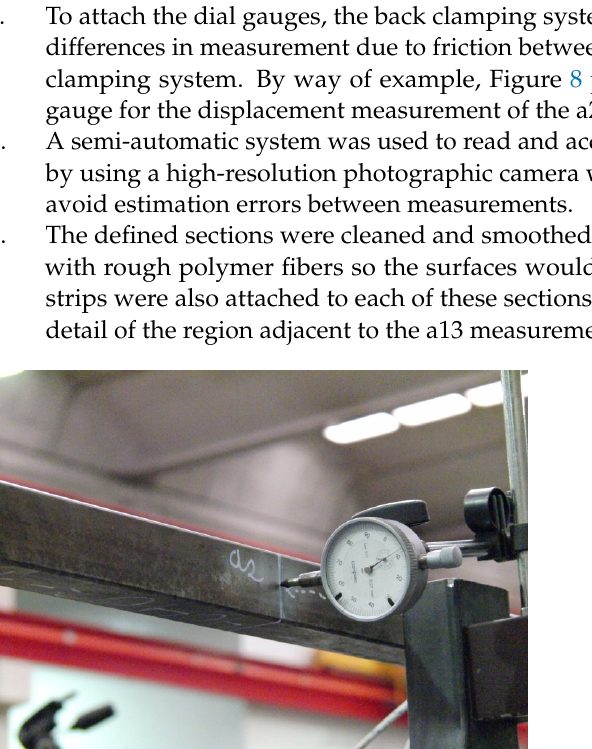
Figure 8. Mounting of the dial gauge for the displacement measurement of the a2 section.